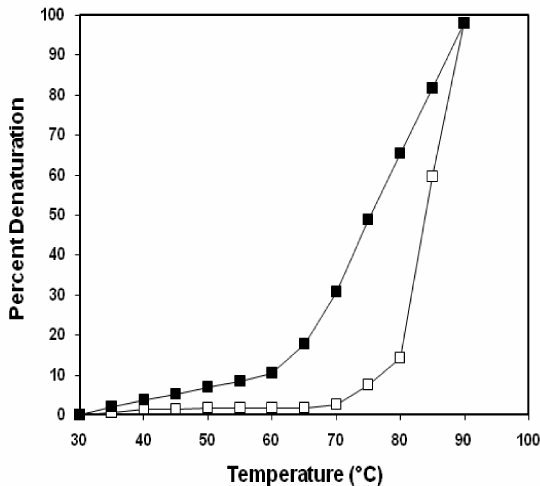
Figure 2. Thermal melting profile of native human DNA ( (cid:3) ) and N -OH-AABP-modified human DNA ( (cid:4) ). The thermal denaturation experiment was performed in triplicate. The drop in Tm is statistically significant for modified human DNA as compared to the native human DNA.